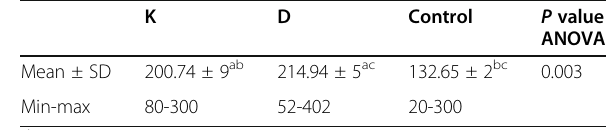
Table 3 Mean interval (min) of first analgesic intake by patients after surgery